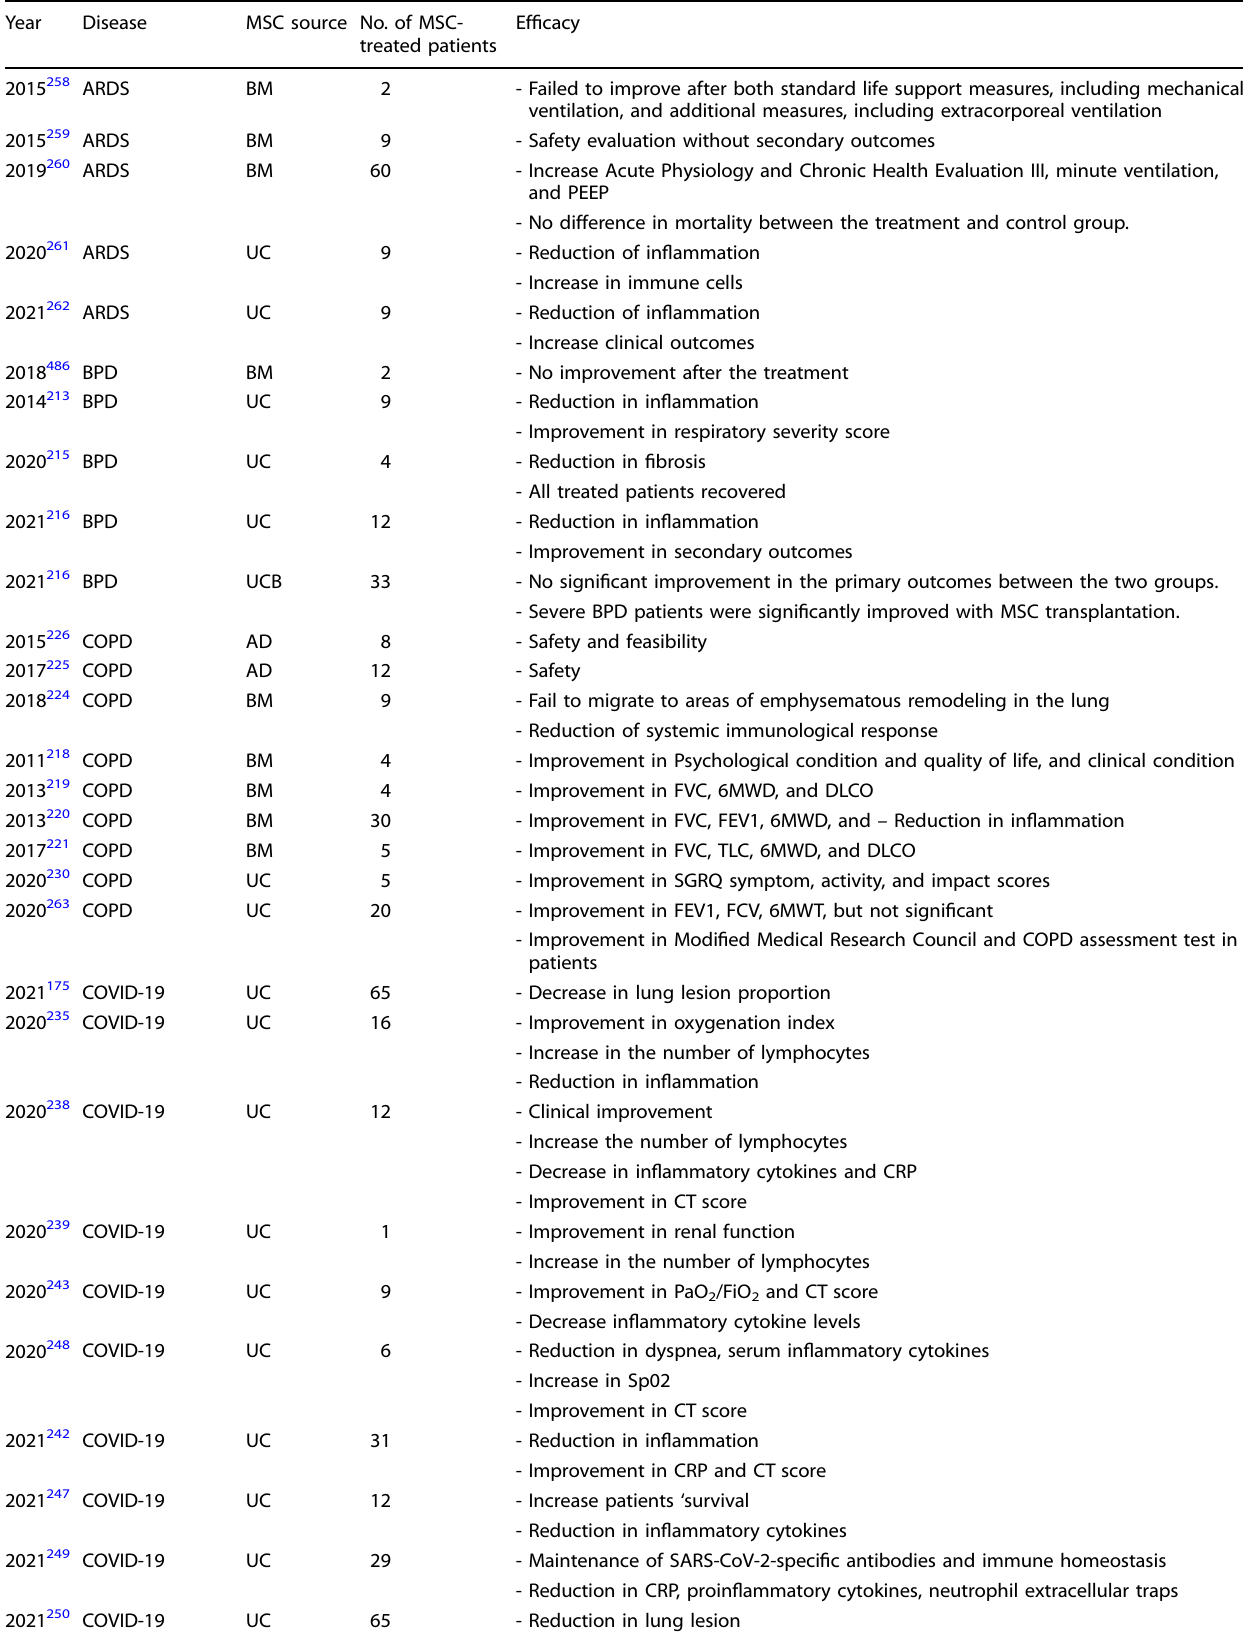
Table 2. The reported clinical trials using MSCs from AT, BM, and UC in the treatment of respiratory diseases Year Disease - Failed to improve after both standard life support measures, including mechanical ventilation, and additional measures, including extracorporeal ventilation - Increase Acute Physiology and Chronic Health Evaluation III, minute ventilation, and PEEP - No difference in mortality between the treatment and control